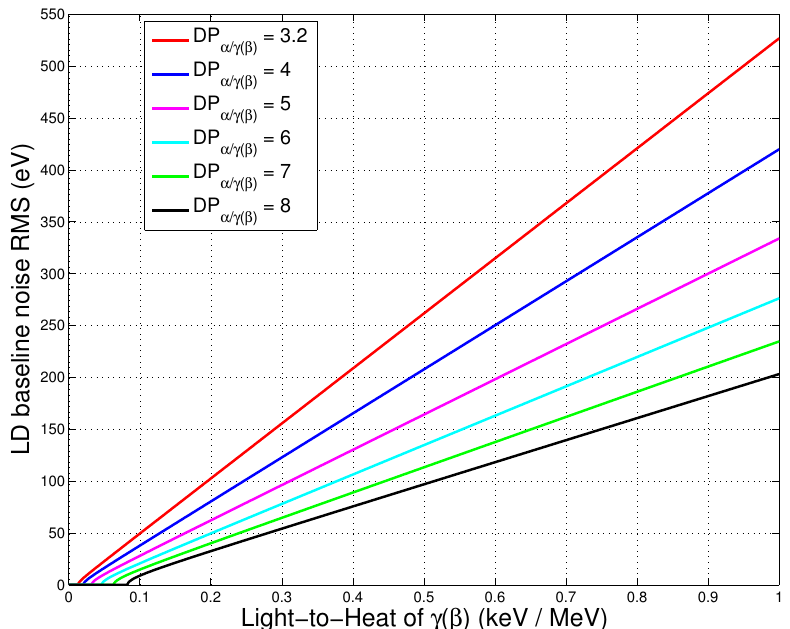
Figure 4. Discrimination power DP α / γ ( β ) expected at 3 MeV ( 100 Mo 0 ν DBD region-of-interest (ROI)) as a function of the LD noise resolution and the relative scintillation signal of a scintillating bolometer expressed by the L / H γ ( β ) parameter. The used quenching factor for alpha particles (0.2) and an average photon energy (2.07 eV) are taken as for lithium molybdate scintillating bolometers. The smallest DP value present in Figure 4 corresponds to the minimal α / γ ( β α / γ ( β )